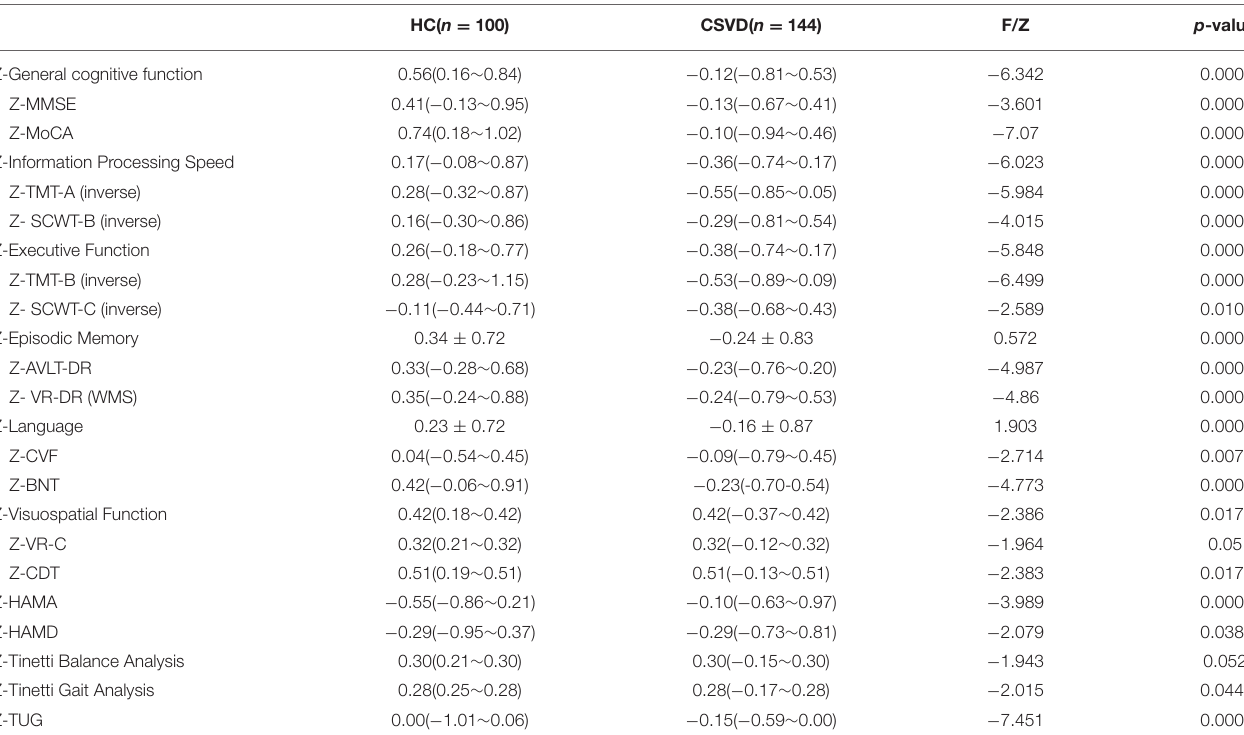
TABLE 3 | Z-scores of neuropsychological